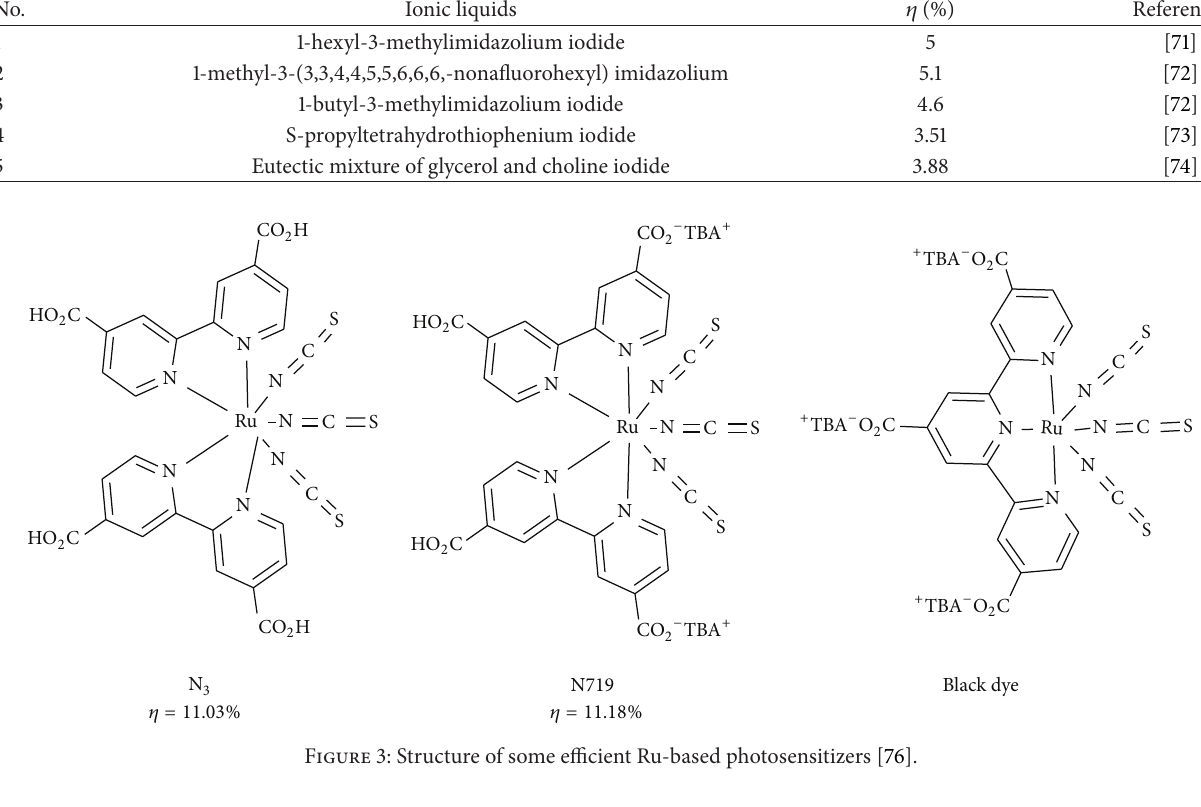
Figure 3: Structure of some efficient Ru-based photosensitizers [76].